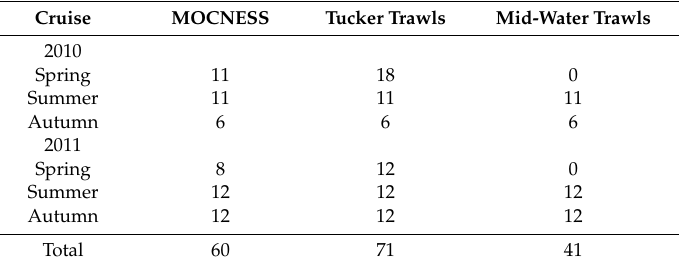
Table A3. Mean concentrations ( ± S.D.) (ind. m − 3 ) of copepods ( Acartia tonsa ), bay anchovies ( Anchoa mitchilli ), ctenophore ( Mnemiopsis leidyi ), and bay nettles ( Chrysaora chesapeakei ) collected from the North and South Stations during the 2010 cruises. Species / Stage